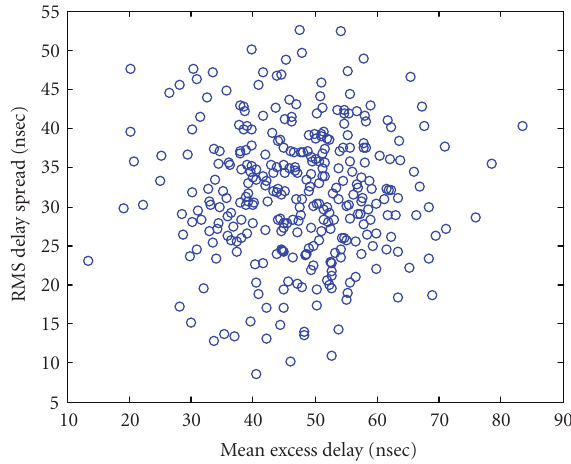
Figure 11: RMS delay spread versus distance, NLOS (15dB threshold).